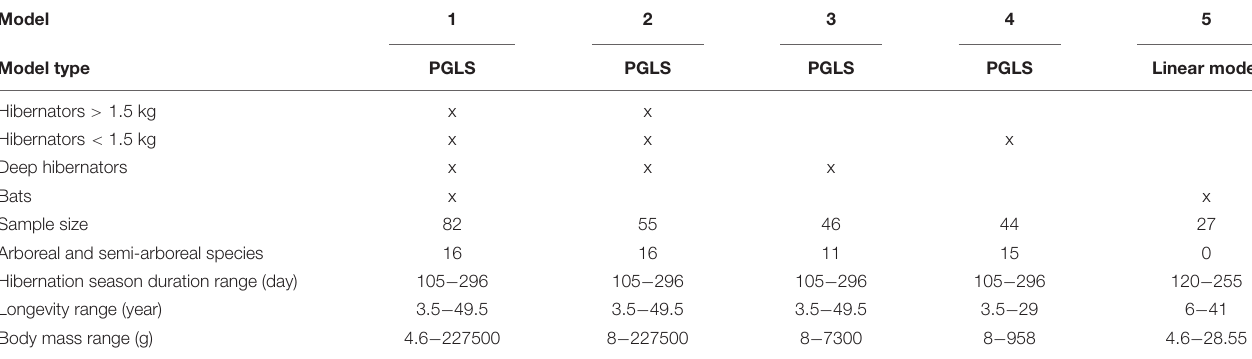
TABLE 1 | Summary of models and datasets.